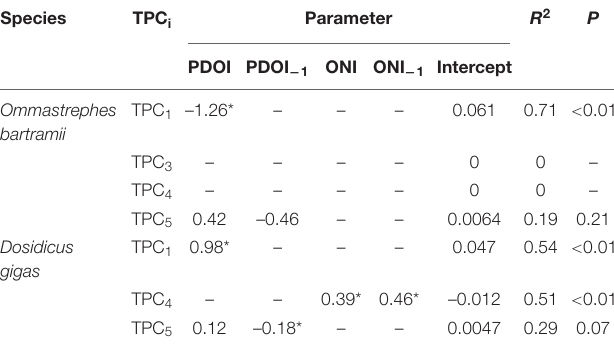
TABLE 3 | Best results for the relationship between each significant trend series of principal component (TPC i ) and climate indices (Pacific Decadal Oscillation Index, PDOI, and Oceanic Niño Index, ONI. “–1” at the subscript of PDOI and ONI indicates its 1-year-lag effect). Species